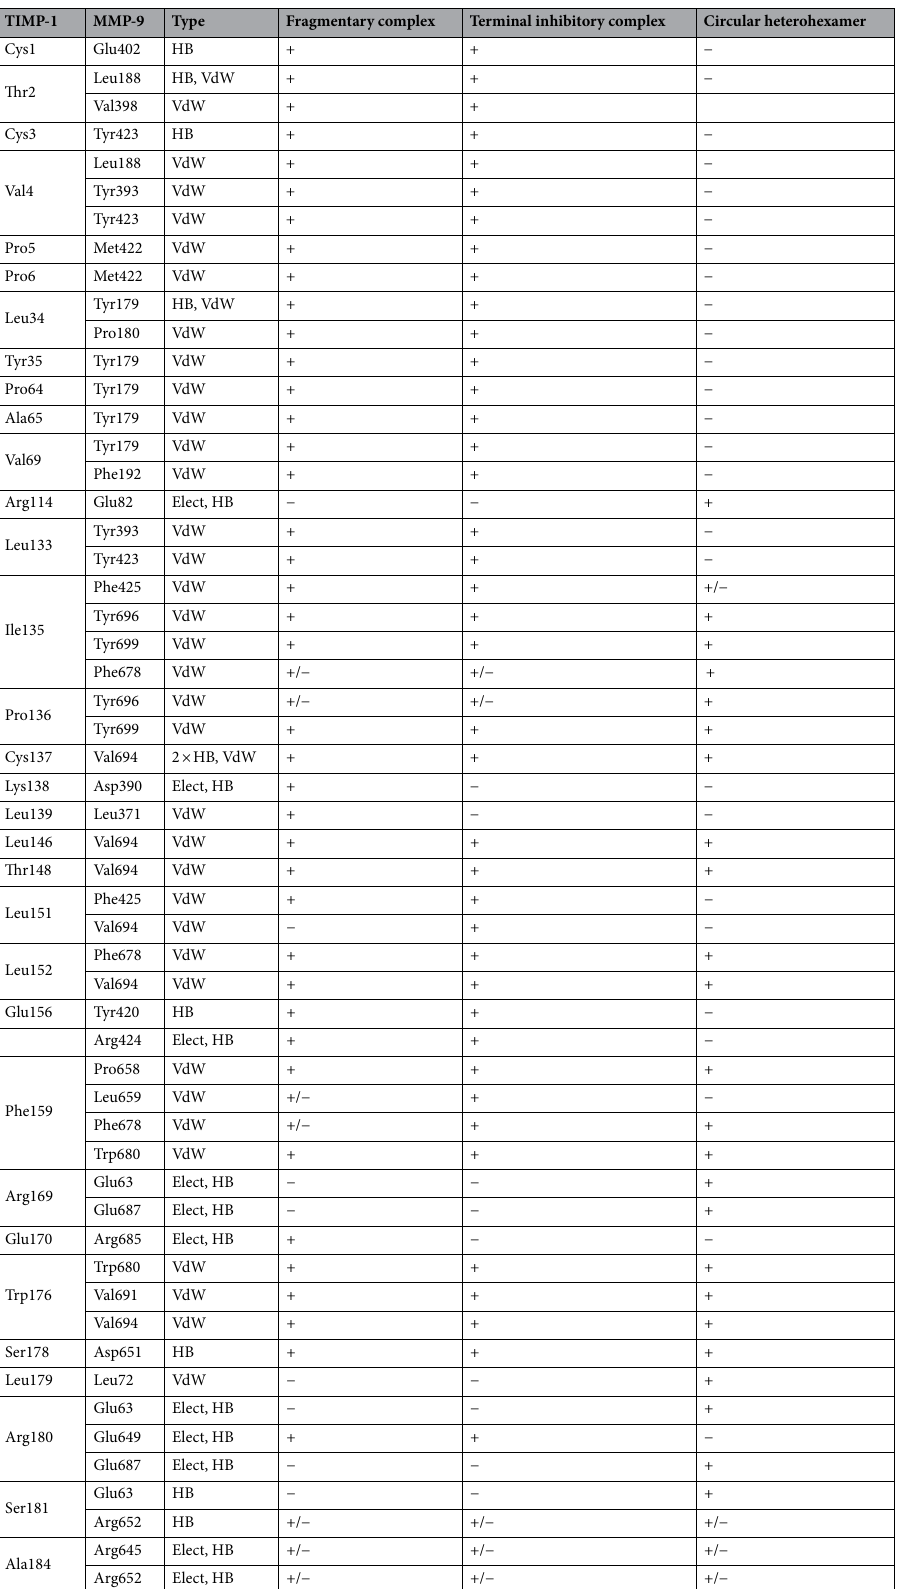
Table 1. The most important interactions stabilising the MMP-9–TIMP-1 complexes. Hydrogen bonds (HB), Van der Waals (VdW), and Coulomb electrostatic interactions (Elect) are marked as follows: ‘+’ indicates stable interactions, ‘−’ the absent ones, and ‘+/−’ those that were repetitively formed and dissociated during